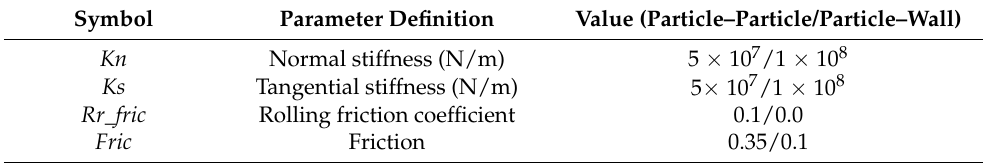
Figure 11. Illustration of ( a ) calibration results of the DEM model and ( b ) corresponding DEM and laboratory specimens at failure. Table 4. The calibrated micromechanical parameters of the DEM model.